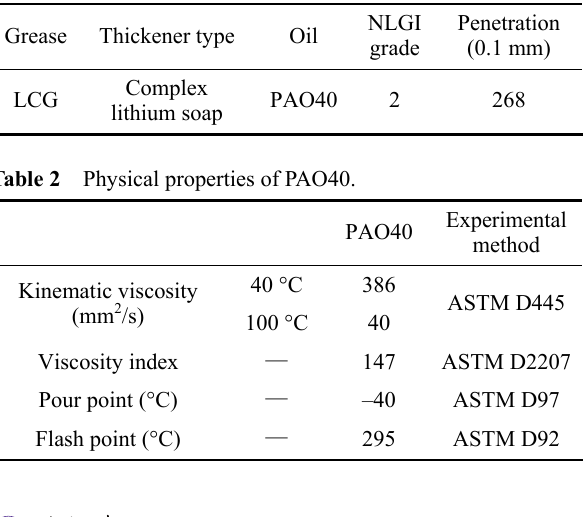
Table 1 Physical properties of LCG.